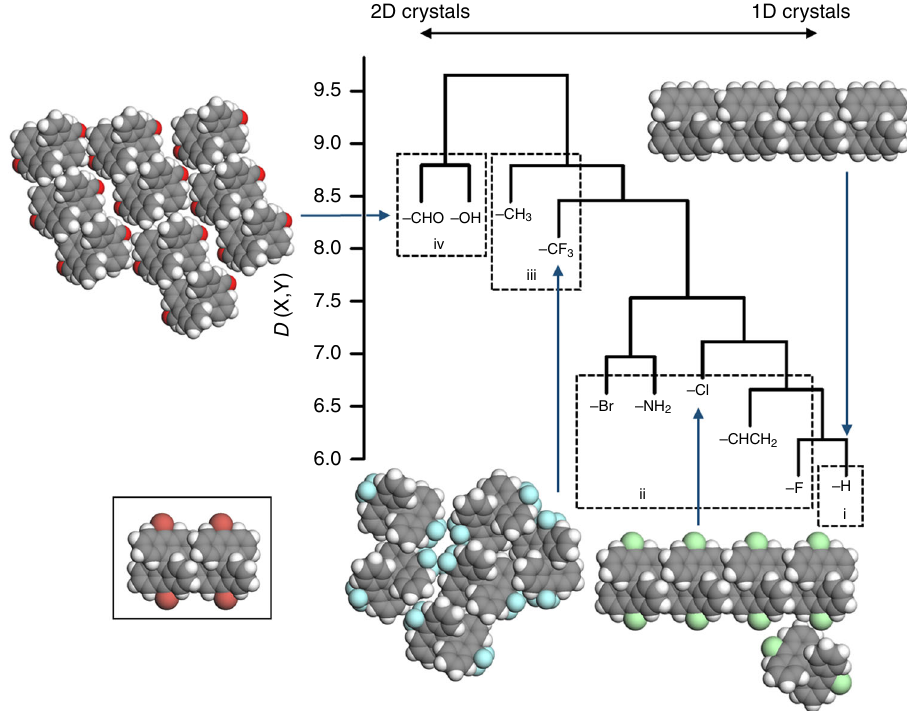
Fig. 4 Hierarchical clustering for bianthracene molecules. In this diagram (dendrogram), bianthracene functional groups are arranged according to the similarity of the islands formed upon molecular self-assembly on Cu(111) at 200 K. Functional groups on the right-hand side have a strong tendency to form chain-shaped islands (1D crystals), whereas functional groups on the left-hand side have a strong tendency to form 2D tilings (2D crystals). Functional groups between these two extremes produce intermediate structures. In order to interpret the dendrogram, we divide the functional groups into four categories, as indicated by the dotted boxes. From right to left, the boxes correspond to the Strong 1D Crystal Formers (category i), Moderate 1D Crystal Formers (category ii), Weak 1D Crystal Formers (category iii), and Strong 2D Crystal Formers (category iv). Some island shapes for various functional groups are shown surrounding the dendrogram. The insert shows two bianthracene molecules aligned in the direction of their bianthracene tips. Gray spheres = carbon, white spheres = hydrogen, red – brown spheres = bromine, blue spheres = nitrogen, green spheres = chlorine, and bright red spheres